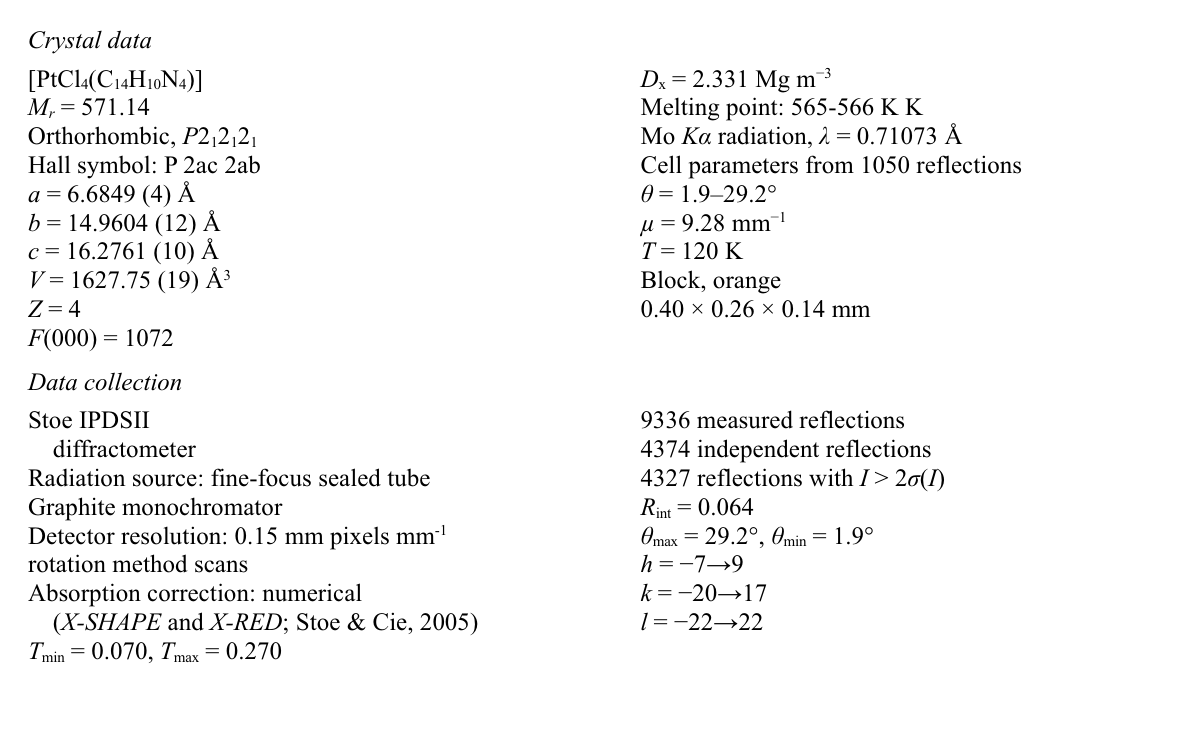
Figure 2 A packing diagram for (I). Hydrogen bonds are shown as dashed lines. Tetrachlorido(2,3-di-2-pyridylpyrazine- κ 2 N 1 , N 2